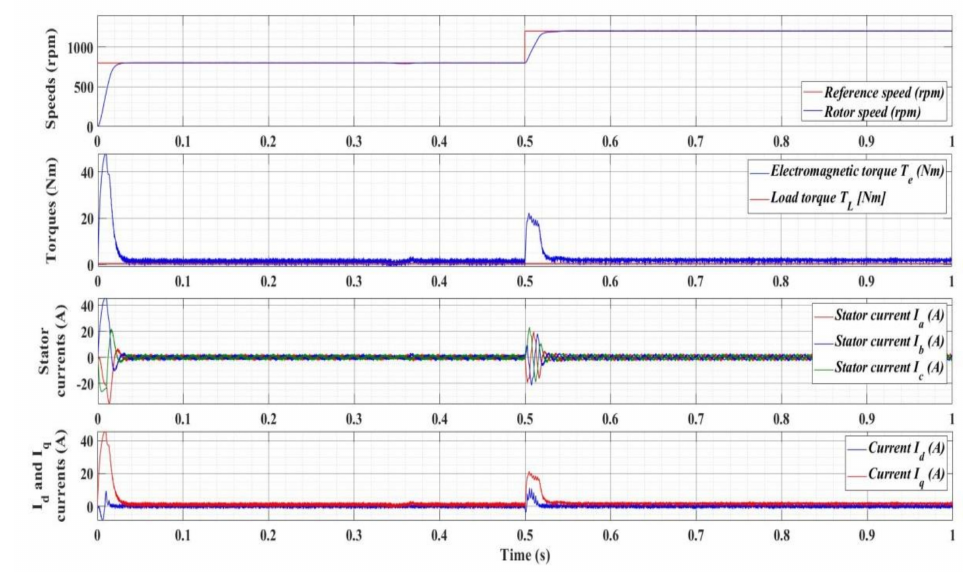
Figure 31. Time evolution for the numerical simulation of the PMSM control system based on the RL-TD3 agent for the correction of u dref , u qref , and i qref .